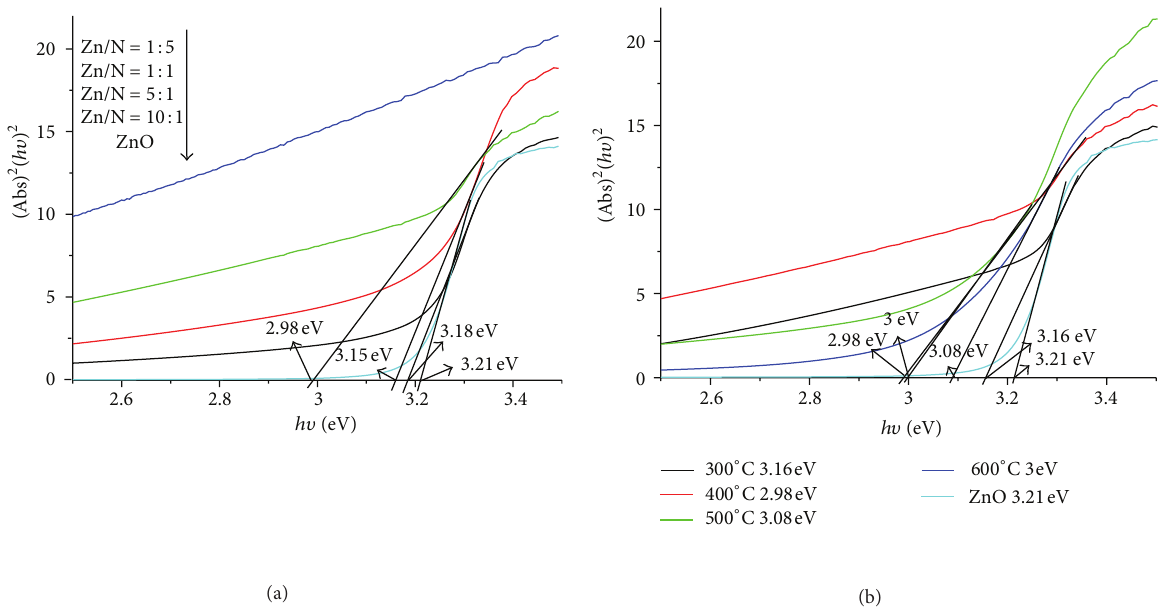
Figure 2: UV-vis absorption spectra in the band-gap region of samples: (a) samples with different Zn/N molar ratios calcined at; 400 ∘ C; (b) samples with Zn/N = 1: 1 molar ratios calcined at different temperatures.